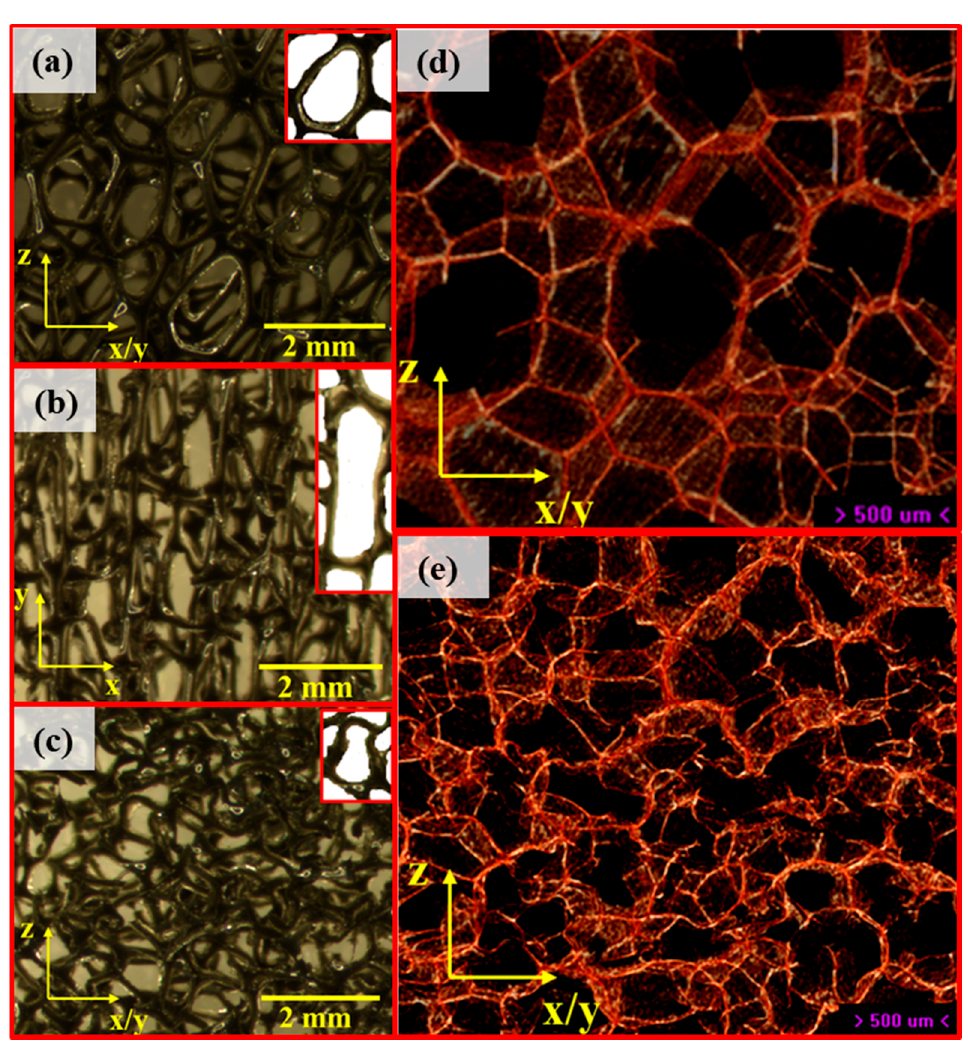
Figure 3. Microscopic images of 1 to 2 mm thick slices of ( a ) unconverted open cell foam, ( b ) anisotropic open cell foam, ( c ) triaxial open cell foam. Inserts in ( a ) to ( c ) show single cells with underlying unconnected ribs removed. ( d,e ) Renderings from micro-computed tomographic of ~4 × 5 × 20 mm samples of ( d ) unconverted closed cell foam and ( e ) triaxial closed cell foam.